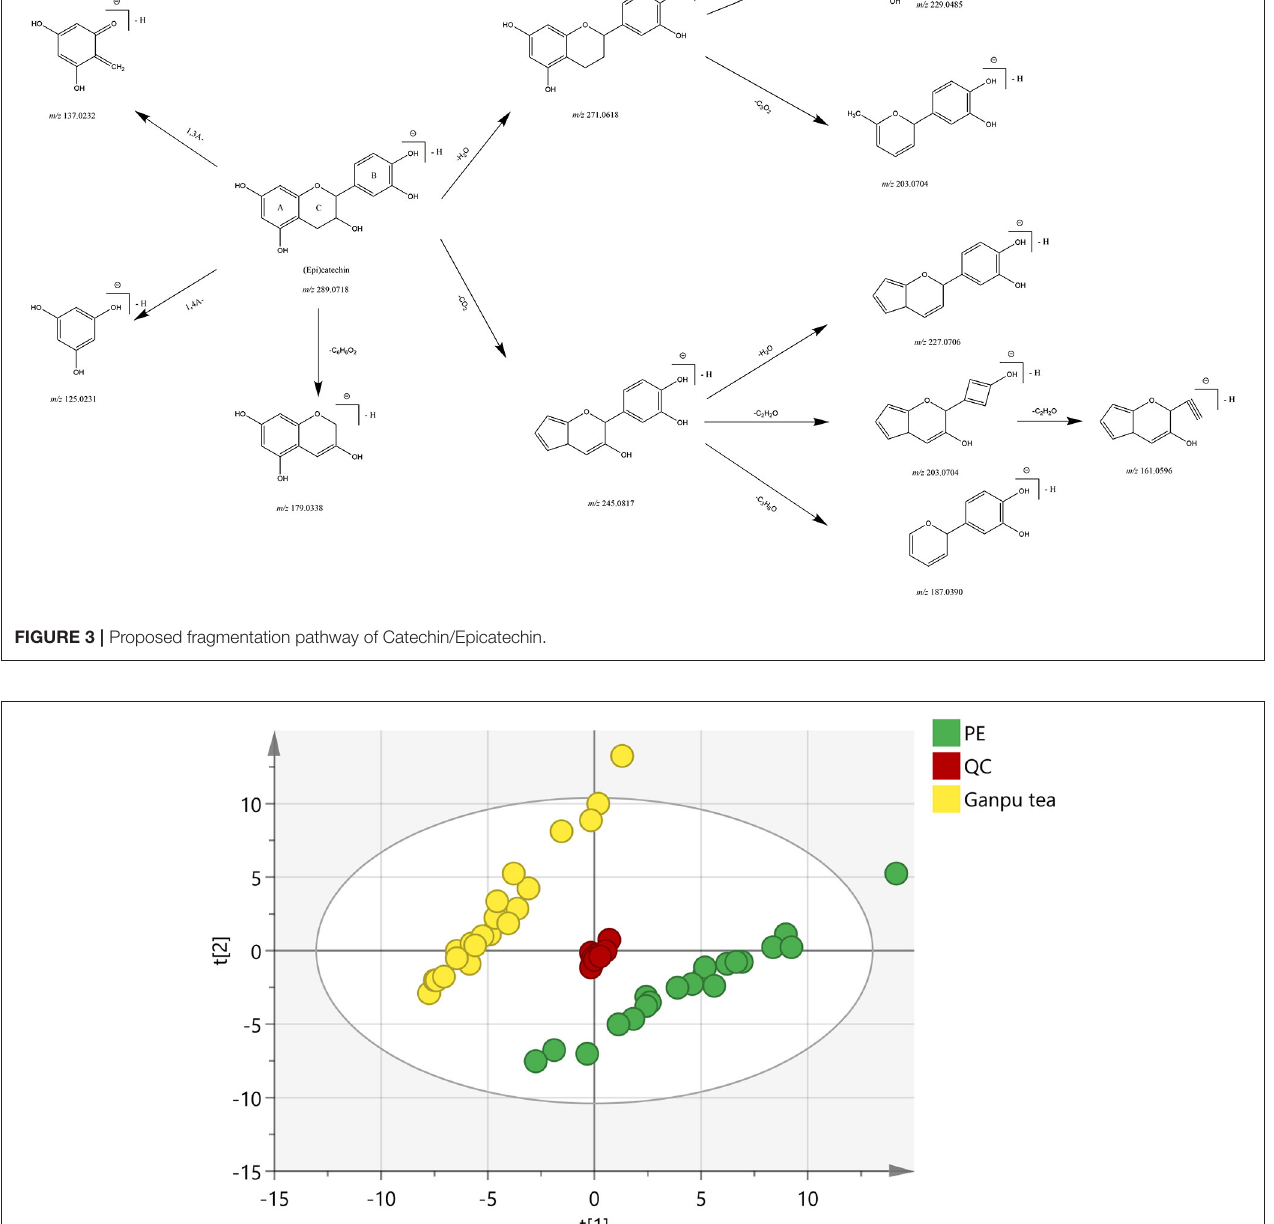
evaluate the intraday and inter-day precision, respectively, which were then calculated and expressed as relative standard deviation